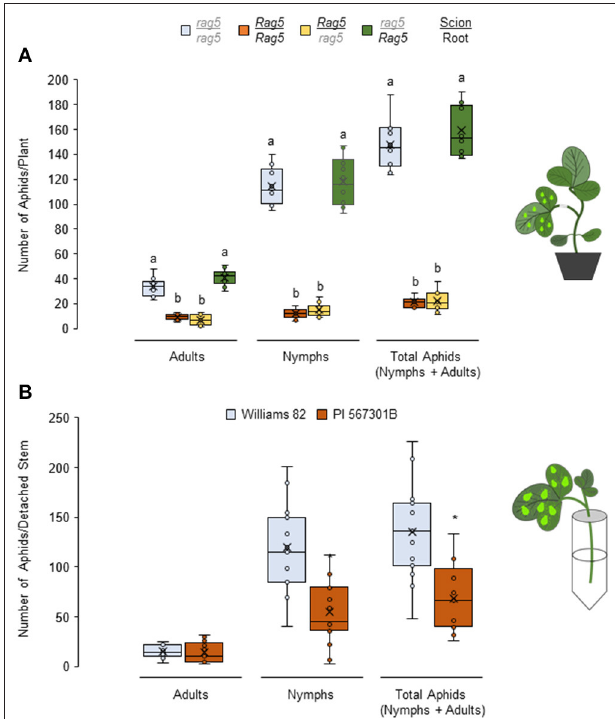
FIGURE 3 | Rag5- mediated resistance to soybean aphids is derived from the stems. Populations of soybean aphids in (A) chimeric reciprocally grafted plants and in (B) detached stems of Williams and PI 567301B. For both (A,B) , the numbers of adults and nymphs are recorded daily for 4 days, and data for day 4 are shown. In (A) , the values are mean ± standard error of mean from 10 plants that showed successful graft formation. Different letters above the bars indicate values that are significantly different from each other ( P < 0.05; GLM/ANOVA). In (B) , three replications are performed for each genotype, and the experiment is repeated three times. Asterisks indicates values that are significantly different from each other ( P < 0.05; t -test). The cartoons represent the setup of the reciprocal graft and detached stem assays. Aphid size and number in the cartoons are not drawn to scale.